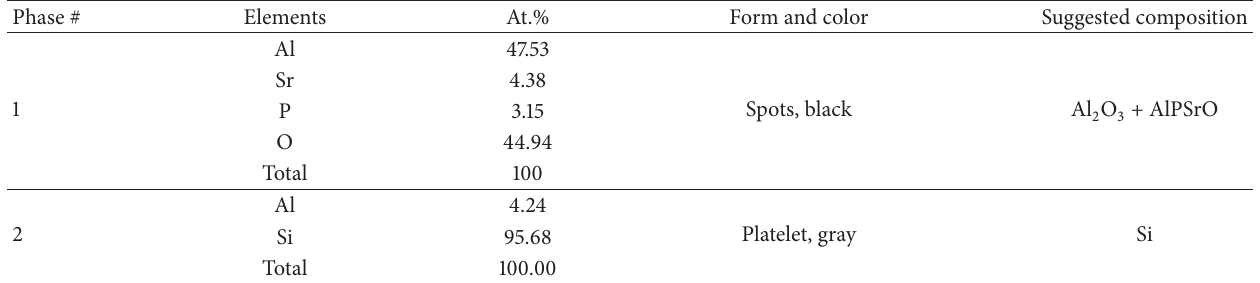
Spots, black Al 2 O 3 + Platelet, gray SiSi 95.68